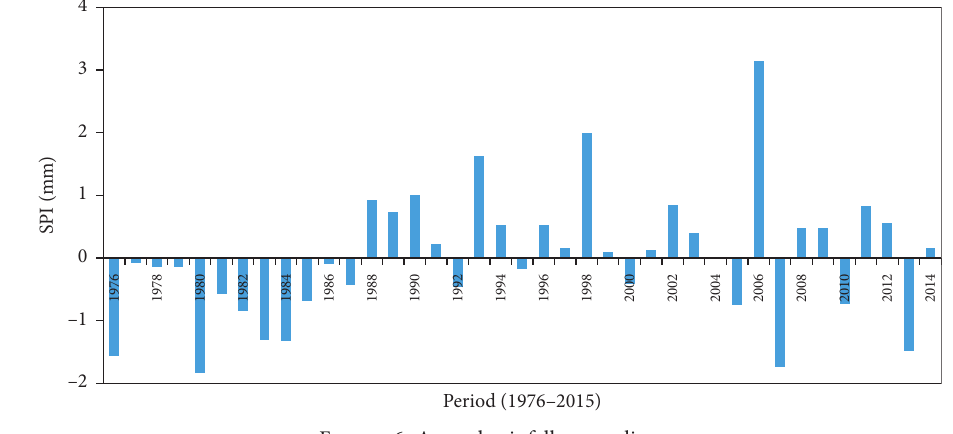
Figure 6: Annual rainfall anomalies.